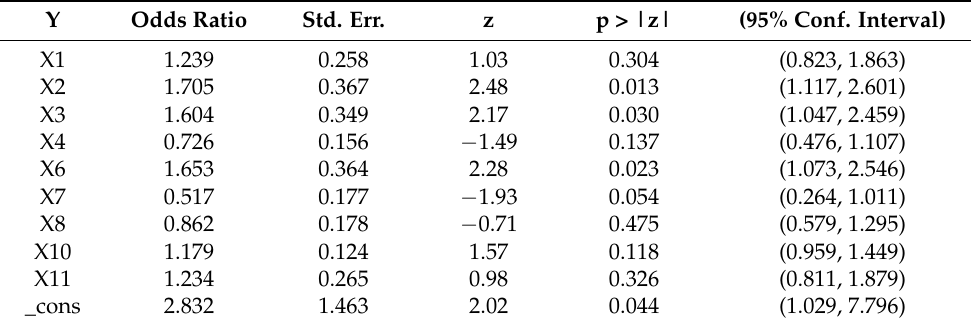
Table A5. The forth step of stepwise logistic regression.